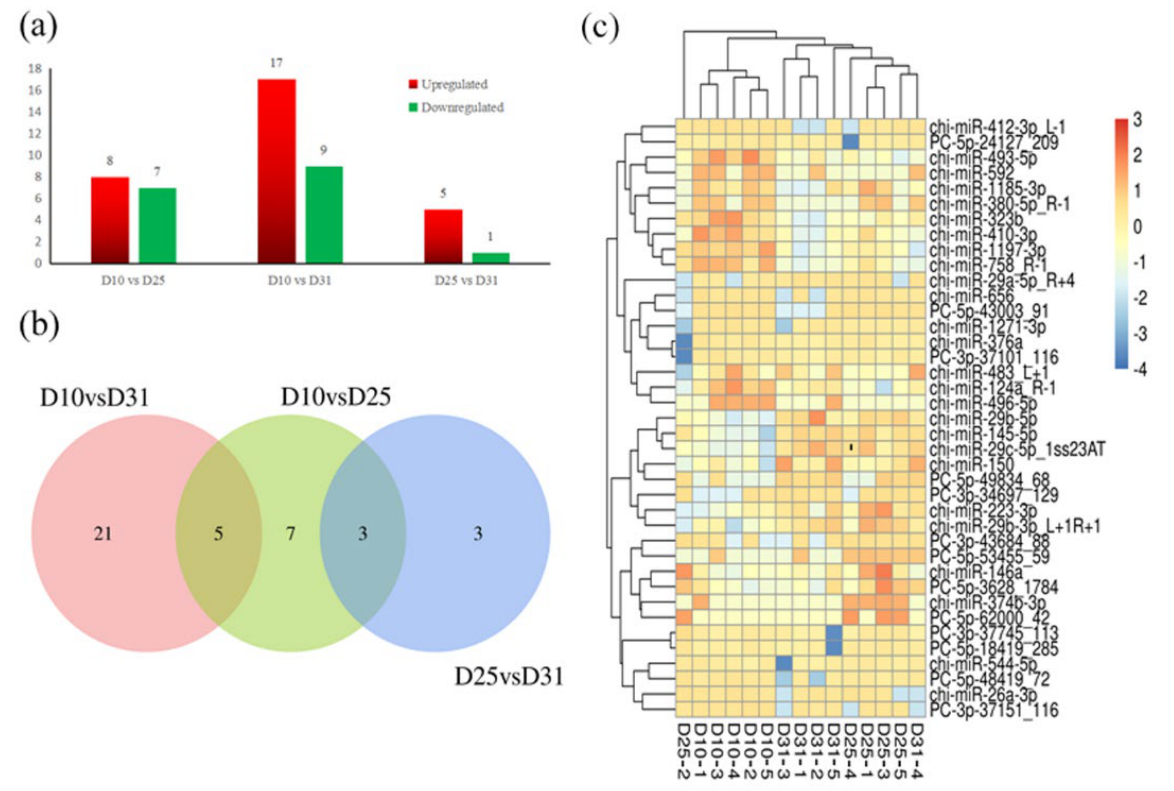
Figure 1. Characterization of differentially expressed miRNAs (DEmiRNAs) in the colon of goats at the preregurgitation stage with a fold change > 2.0 and p < 0.05. ( a ) Numbers of DEmiRNAs in the goat colon at D10, D25, and D30. ( b ) Common and unique DEmiRNAs in different pairwise com- parisons. ( c ) Hierarchical clustering analysis of DEmiRNAs.